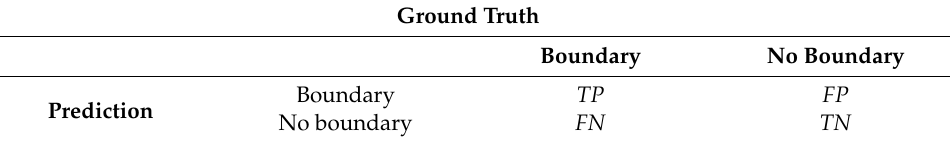
Table 2. Confusion